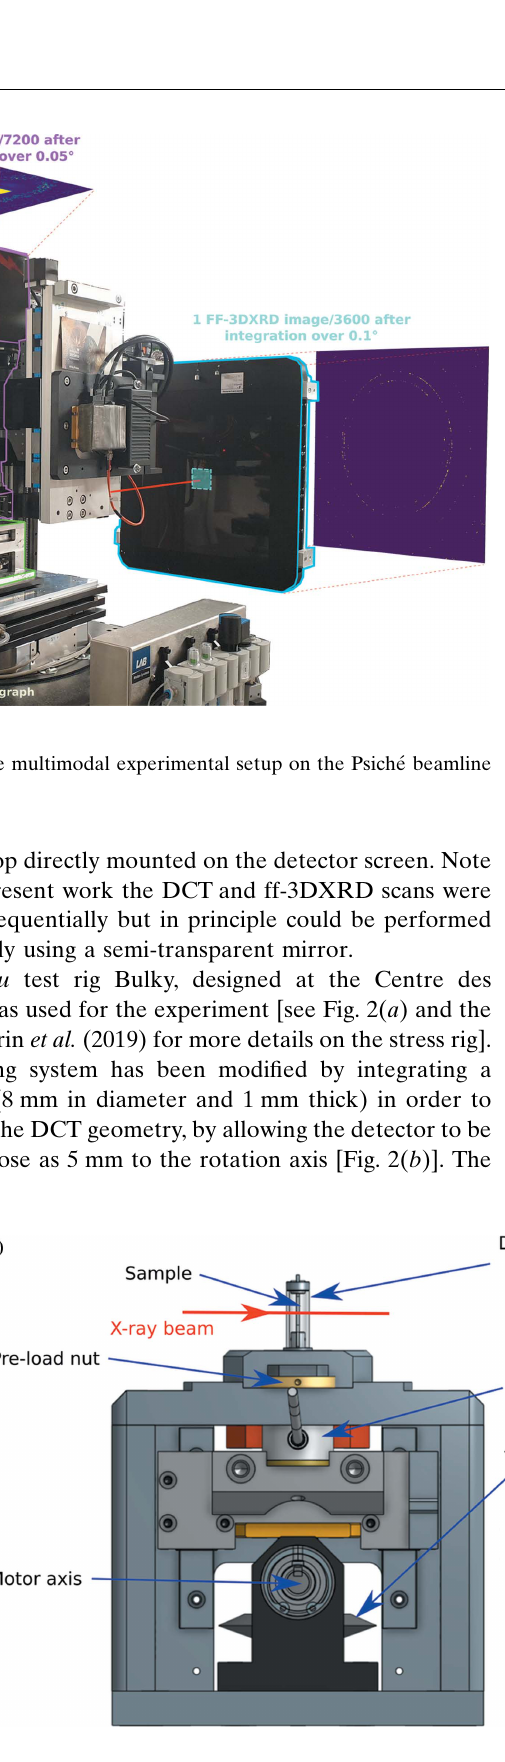
Figure 2 In situ test rig Bulky for DCTacquisition. ( a ) 3D sketch front overview of Bulky with the modified grip system compatible with DCT. ( b ) Bulky installed on Psiche´ tomograph in the DCT acquisition